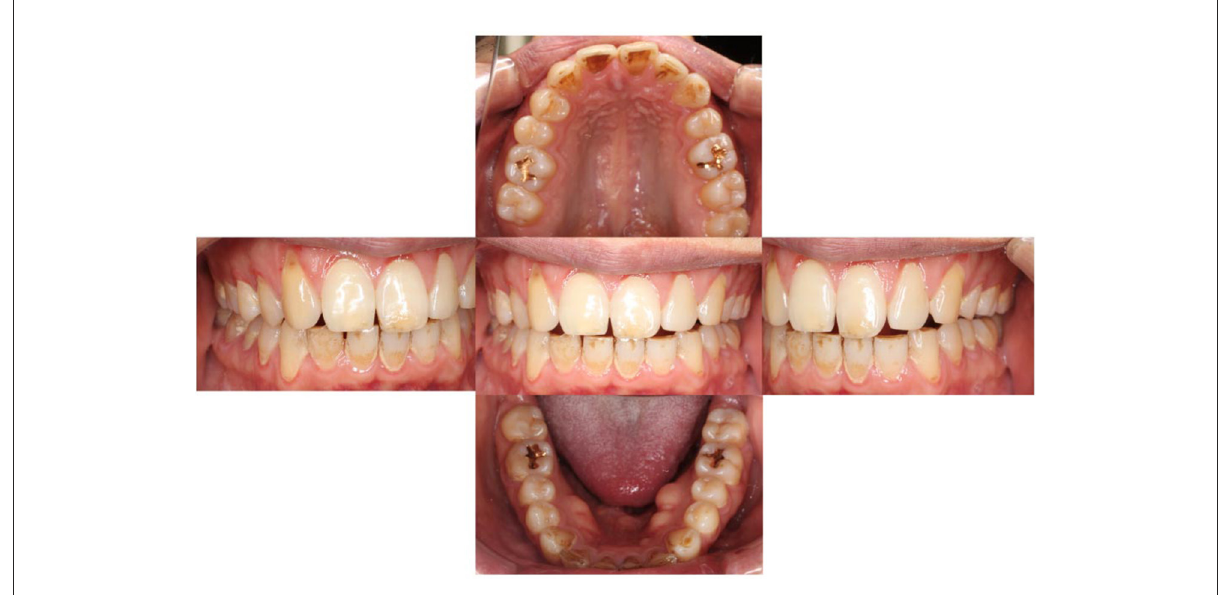
FIGURE1 Intra-oral findings at patient’s first visit to psychosomatic dentistry